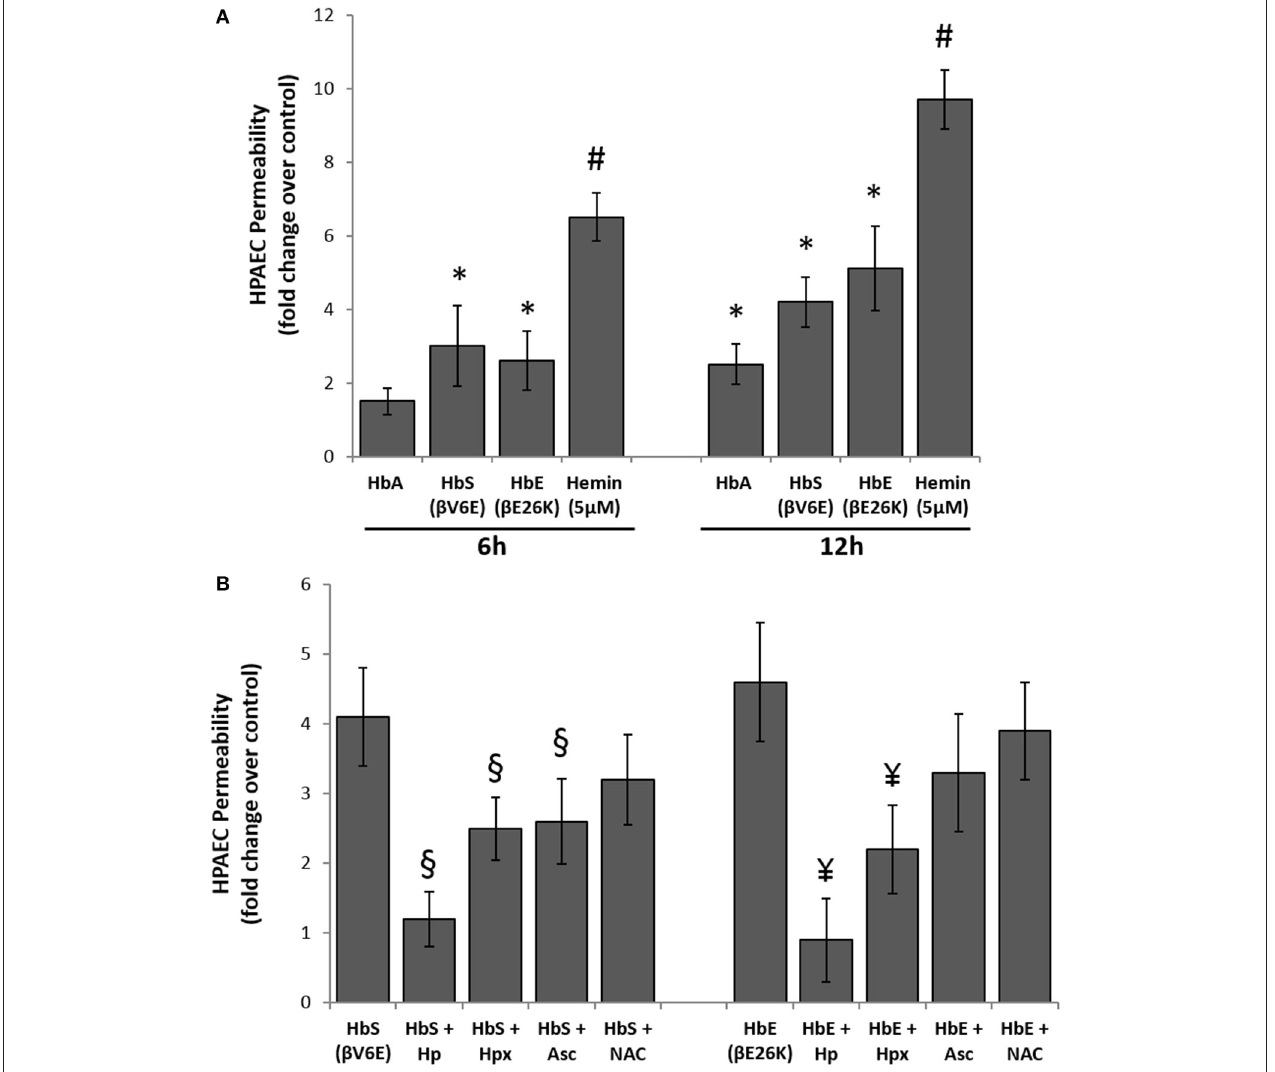
FIGURE 3 | Cell free hemoglobin variants causes disruption of pulmonary endothelial monolayer. (A) HPAEC monolayer were grown on Transwell inserts and then exposed to ferrous forms of HbA or HbS or HbE at equimolar concentration (100 µ M) either for 6 or 12h in the presence of FITC conjugated dextran, 40 KD. Endothelial monolayer integrity was assessed by measuring the passage of FITC-dextran molecule through monolayer. FITC-green fluorescence was monitored by fluorescence plate reader as described in the methods section. Values are presented as average fold difference over control ( N = 3). (B) In a similar set of experiments HPAEC were exposed to either HbS (100 µ M) or HbE (100 µ M) with or without equimolar of either Hp, Hpx or Asc or NAC for 12h in the presence of FITC conjugated dextran. Endothelial monolayer integrity was assessed as mentioned before by measuring FITC-dextran fluorescence in the bottom chamber ( N = 3). Values